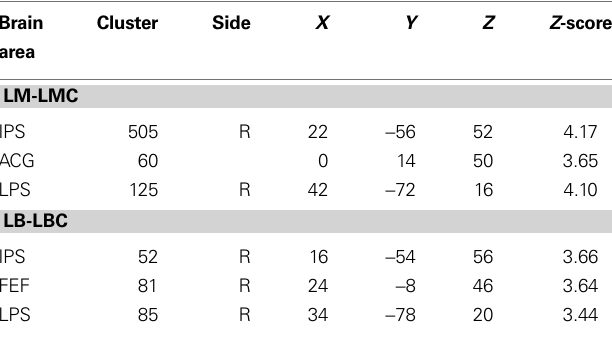
Table 1 | The regions specifi cally activated for LM > LMC and LB > LBC